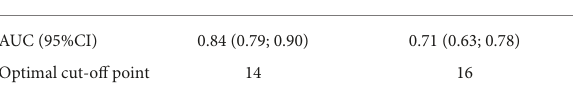
TABLE 4 The CT-SS cutoff points (wave 2, n =